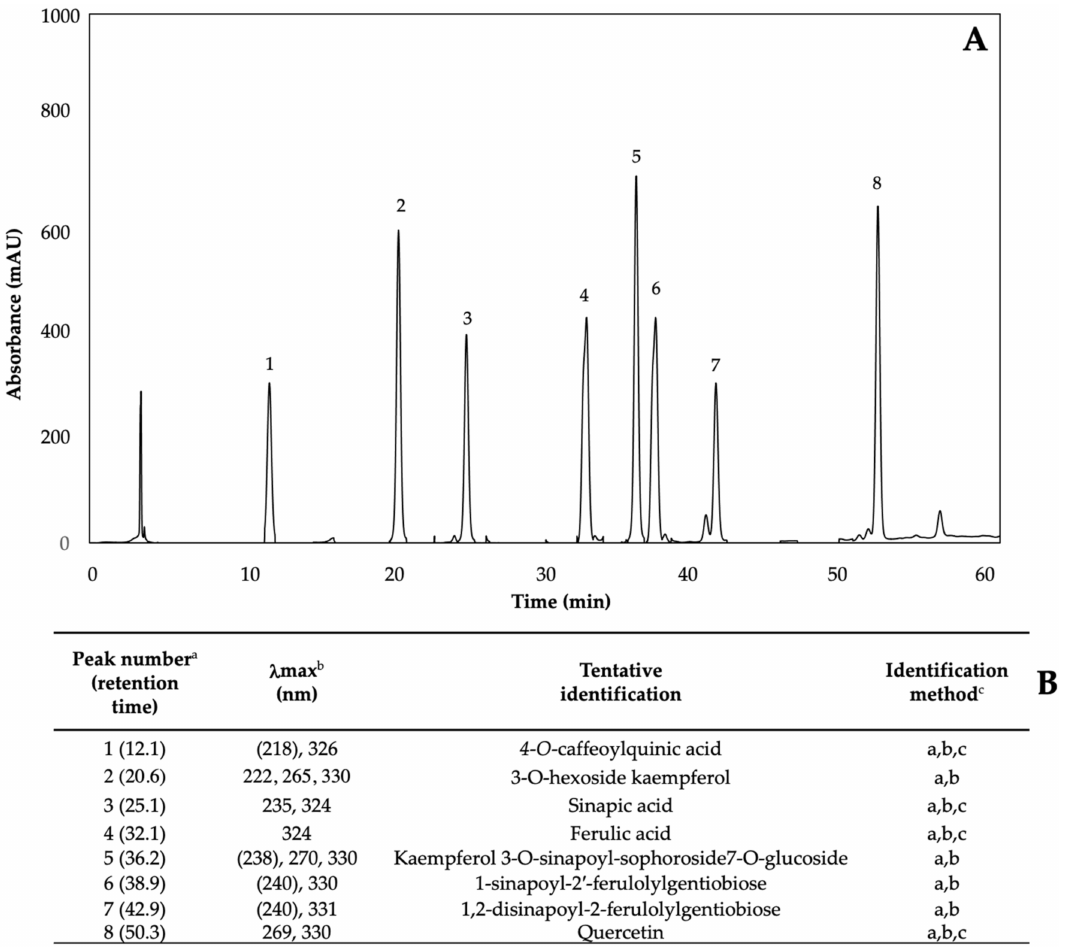
Figure 9. ( A ) HPLC-DAD chromatogram, shown at 320 nm of identified phenolics from ethanol/water (70:30, v / v ) extracts of 7-day-old control (water) kale sprouts. ( B ) Tentative identifica- tion of individual phenolics in kale sprouts was obtained by HPLC-DAD. a Number of peak assigned according to the order of elution from the C 18 reverse phase. b Wavelengths of maximum absorption in the UV/Vis spectra of each chromatographic peak. c Methods considered for identification of each chromatographic peak: (a) Identification by comparison of UV–Visible spectra and wavelengths of maximum absorbance reported in prior literature [5,32,42]; (b) Identification by comparison with the order of chromatographic elution reported by previous authors; (c) Identification by comparison with the retention time and UV–Visible spectra of authentical